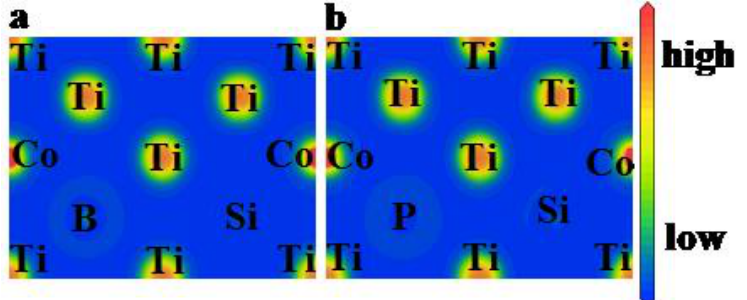
Figure 8. The spin densities of ( a ) Ti 2.25 Co 0.75 Si 0.5 B 0.5 and ( b ) Ti 2.25 Co 0.75 Si 0.5 P 0.5 at the equilibrium lattice parameters.